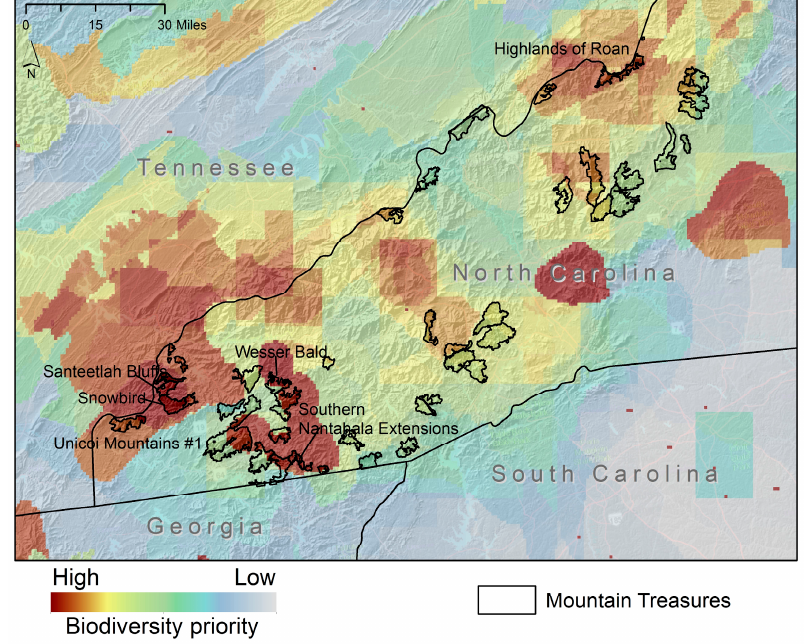
Figure 6. Map of the biodiversity priority index of Jenkins et al. (2015), which identifies key areas